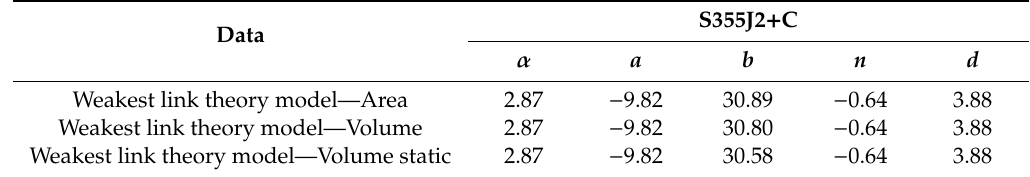
Table 7. Values of the 3-parameters Weibull models for 1.4301.